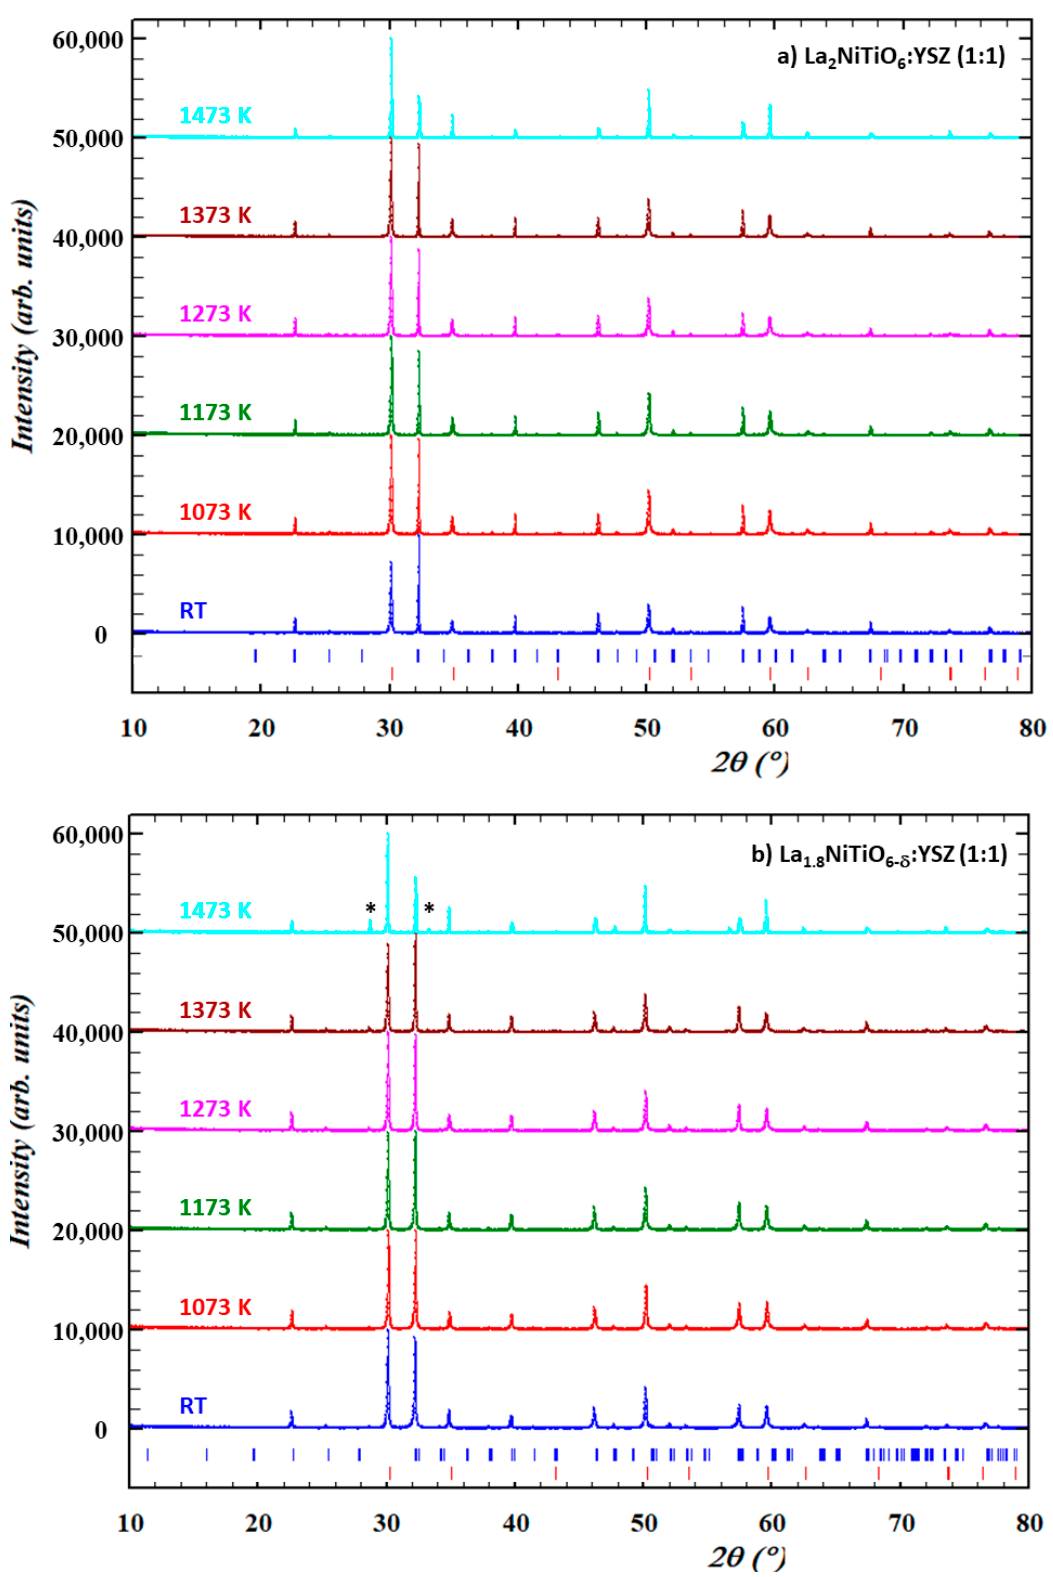
Figure 3. XRD patterns of 1:1 mixture of La 2 − x NiTiO 6 −δ ( a ) x = 0 and ( b ) 0.2 with YSZ in air at RT (blue), 1073 K (red), 1173 K (green), 1273 K (pink), 1373 K (brown), and 1473 K (cyan). Bragg peaks (vertical bars) of corresponding phases are found at the bottom (La 2 − x NiTiO 6 −δ in blue and 8-YSZ in red).